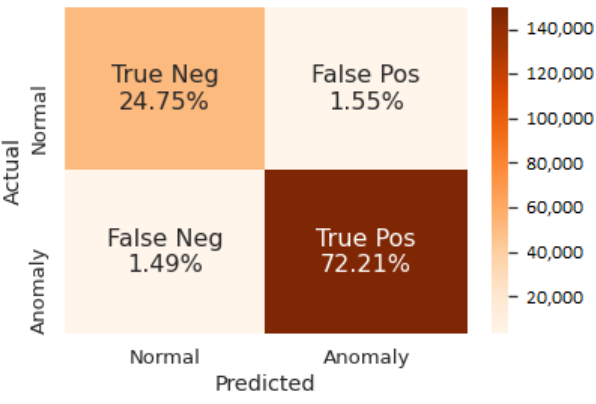
Figure 6. The results presented in a confusion